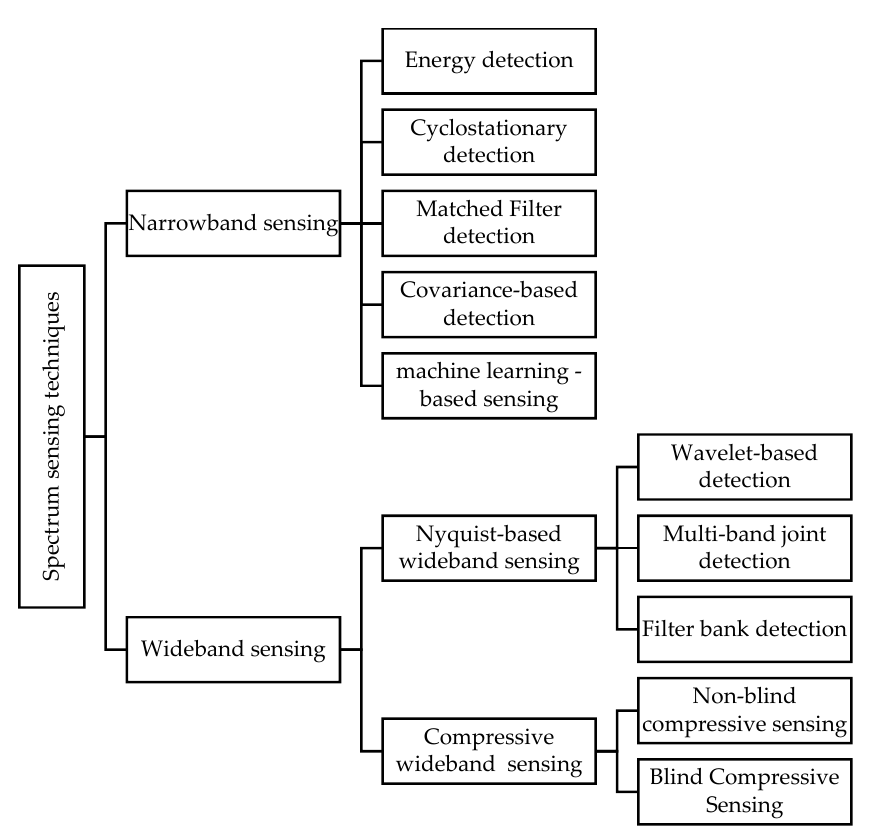
Figure 1. Classification of spectrum sensing techniques.